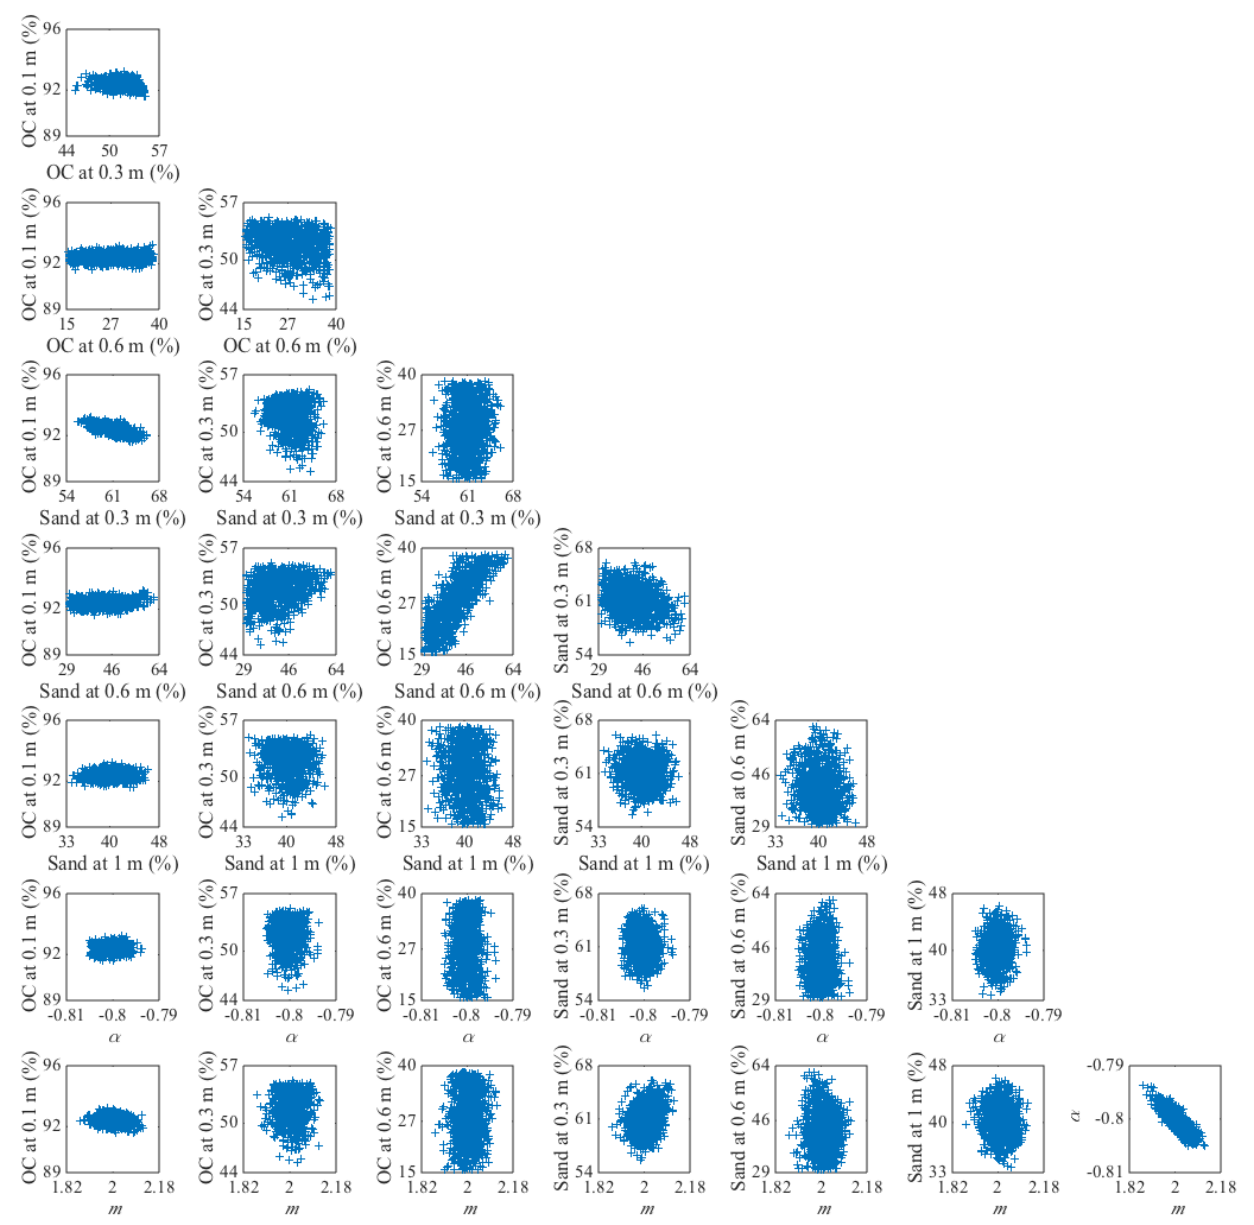
Figure 10. Pairwise relationships between estimated parameters. The calculation was based on 3000 MCMC samples of scenario